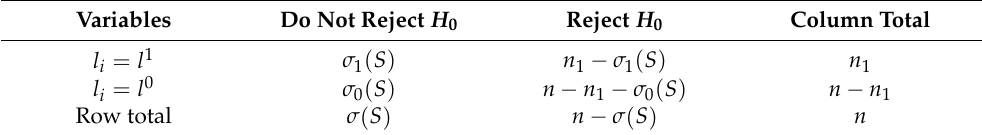
Table 3. A 2 × 2 contingency